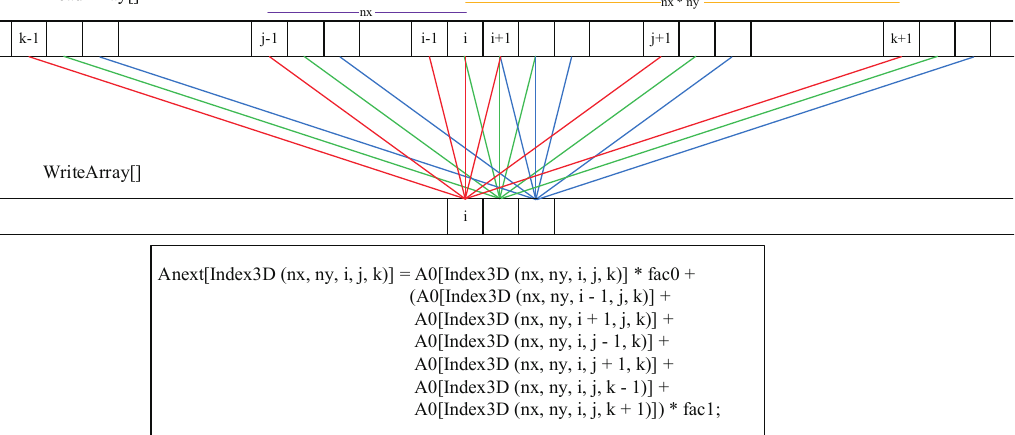
Figure 2. Footprints of a 3D Stencil under linear expression of memory